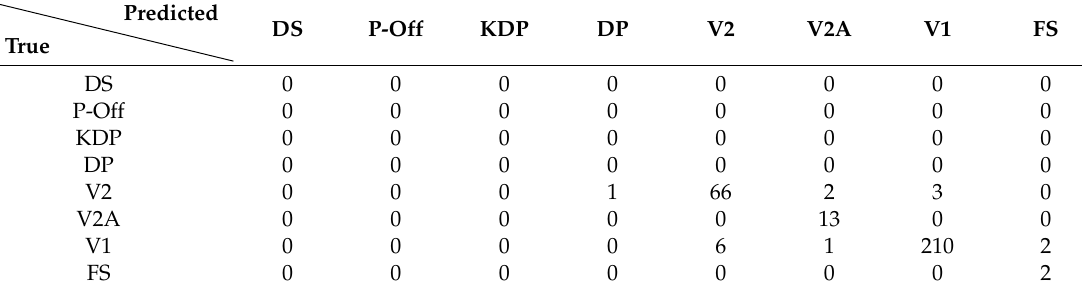
Table 19. Confusion matrix for test set-2 in which the test subject performs all skating techniques on a natural course simultaneously for the sports biomechanics configuration of